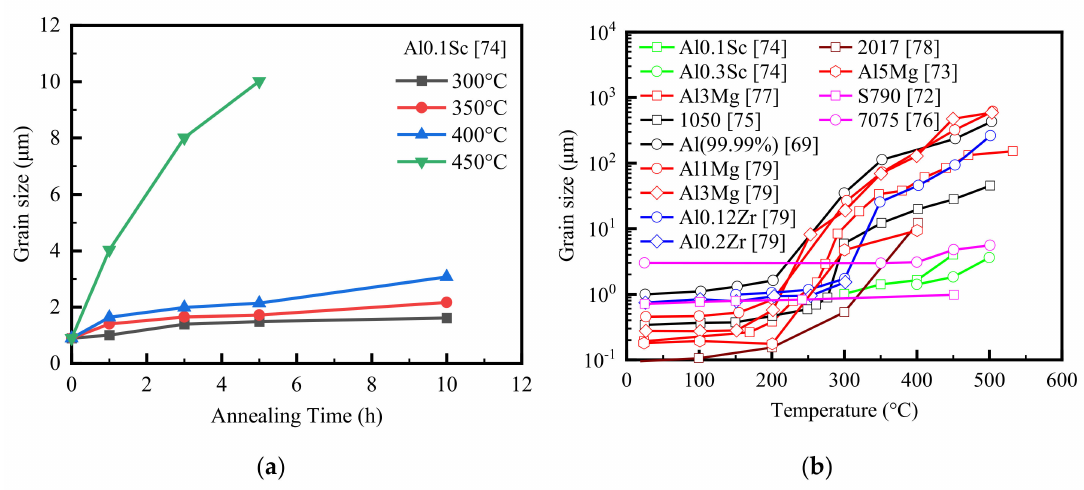
Figure 6. Grain size evolutions ( a ) with time for ECAP-processed Al0.1Sc alloy annealed at various temperatures [74] and ( b ) with temperature for di ff erent Al alloys after 1h annealing